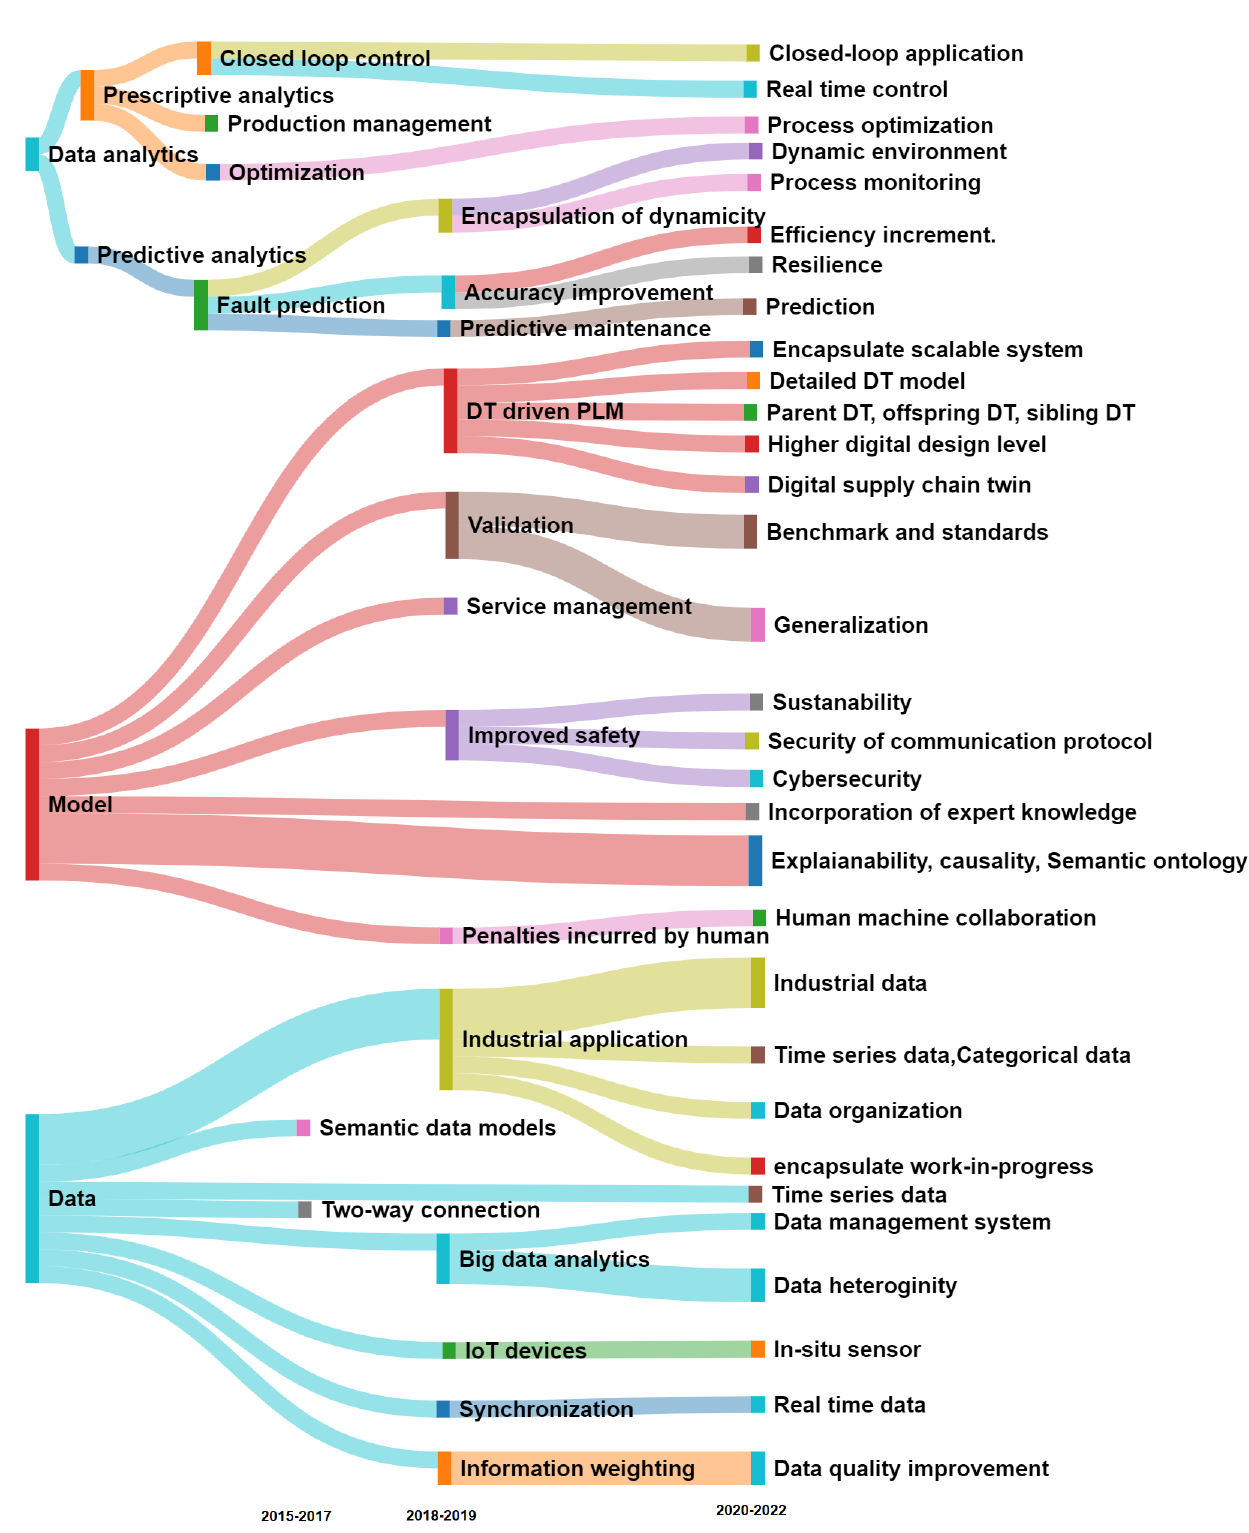
Figure 17. Evolution of future work over time. A sanky diagram showing evolution of future work over three periods of